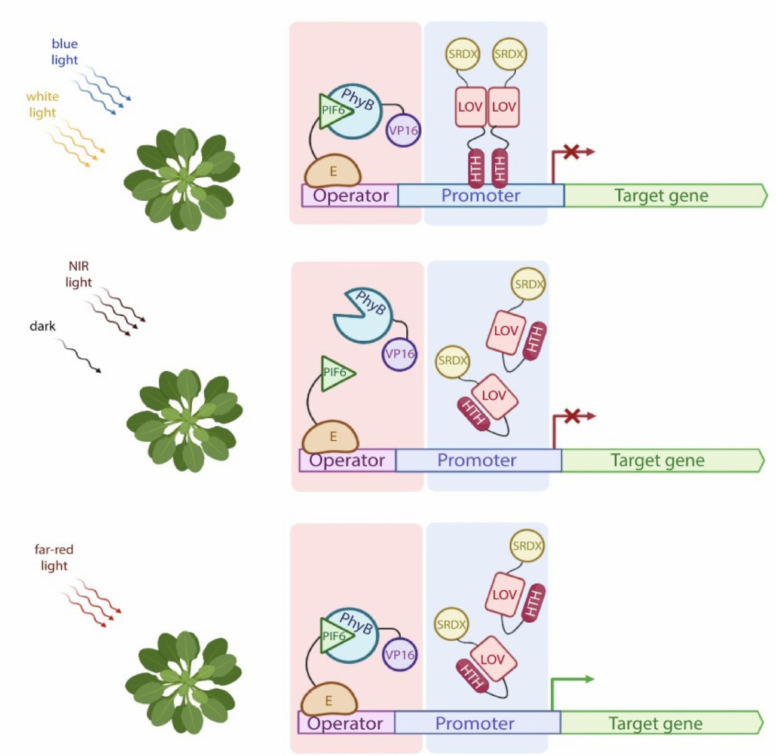
Figure 5. Control of transgene expression in plants using the PULSE system. Upon illumination with blue (460–480 nm) or white light, PhyB interacts with PIF6. However, transcription of the reporter gene is blocked by blue-off module, which is based on the blue light-induced homodimerization of the EL222 LOV domain fused to a plant transcriptional repressor domain SRDX. Under NIR light (740–780 nm) or in darkness, PhyB does not interact with PIF6 and blue-off module is not active. Under far-red illumination (660 nm), blue-off module is also not active, while PhyB and PIF6 form heterodimers, resulting in the transcription activation of the reporter gene. E—DBD of the macrolide repressor protein E. Pink and blue boxes are the far-red light activation and blue light inhibition (blue-off) modules,